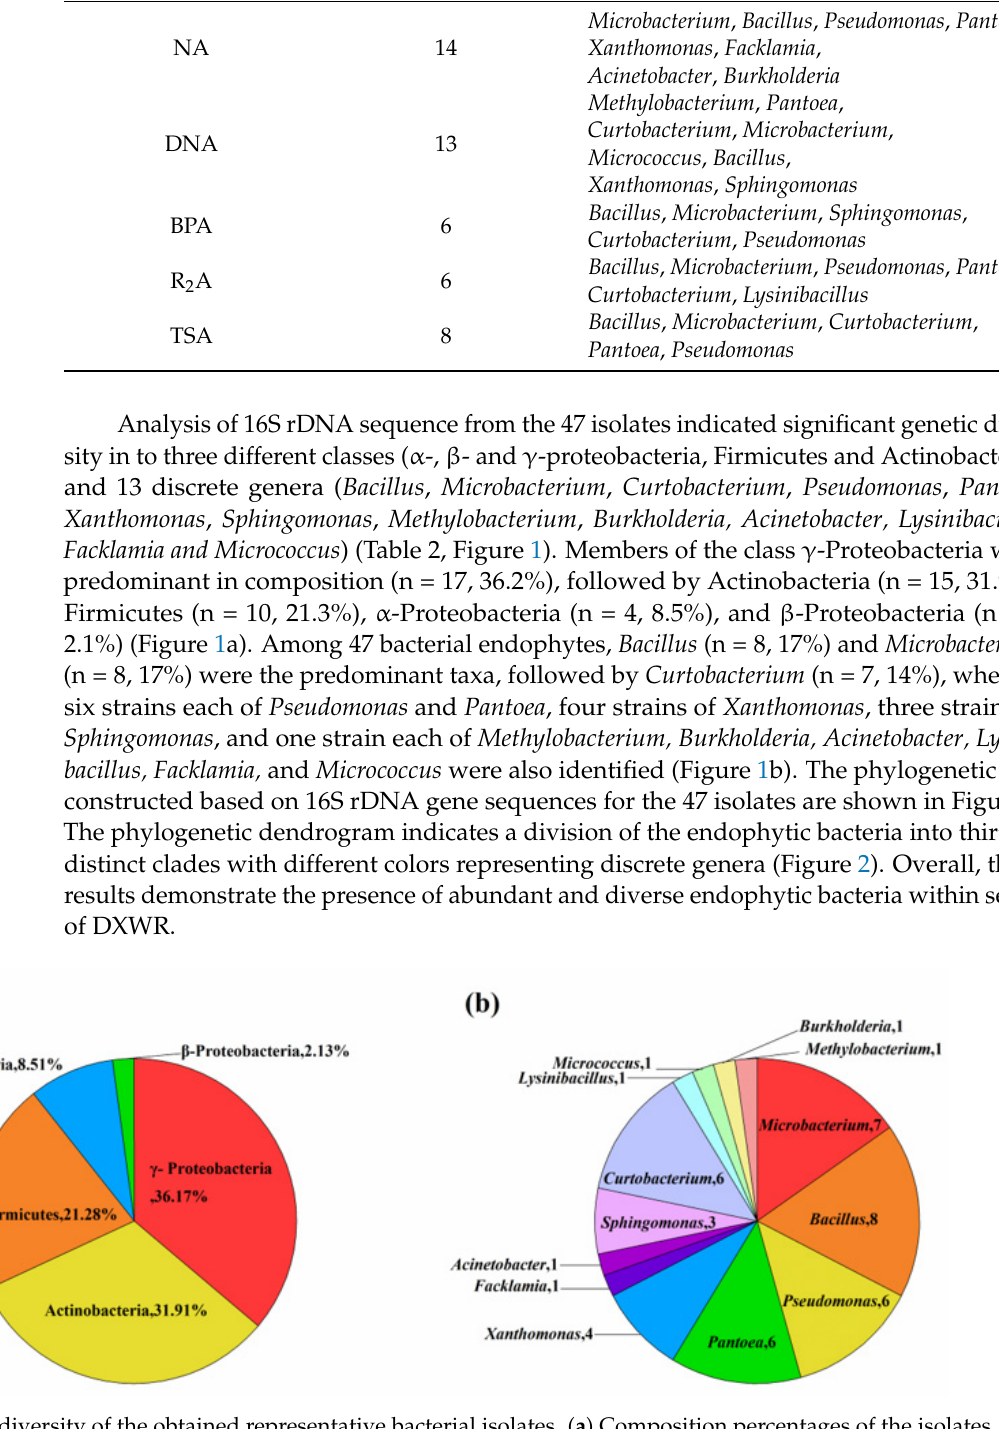
Figure 1. Taxonomic diversity of the obtained representative bacterial isolates. ( a ) Composition percentages of the isolates at the phylum level. ( b ) Numbers of isolates at the genus level.